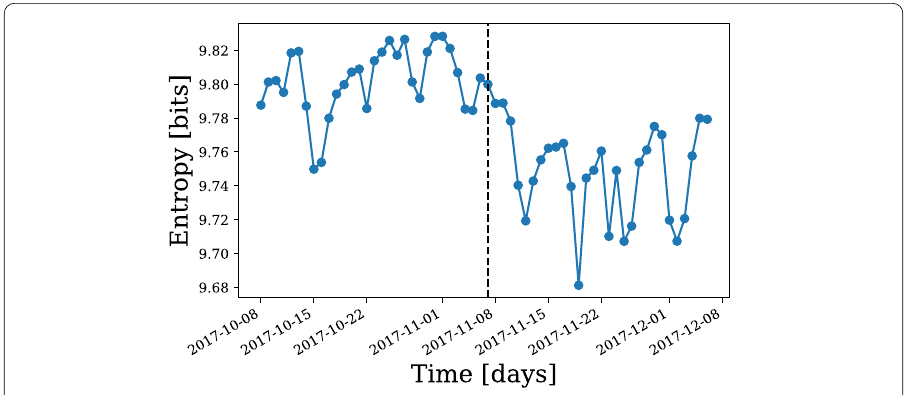
Figure 4 Time series indicating the change in the entropy of Twitter language before and after the platform’s change from 140 character to 280 character tweets (marked by dashed